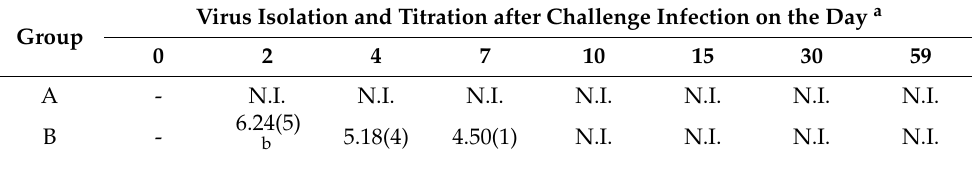
Table 1. BoHV-1 isolation from water buffaloes immunized against BoHV-1 using an inactivated gE-deleted marker vaccine and challenge infected with virulent BoHV-1.